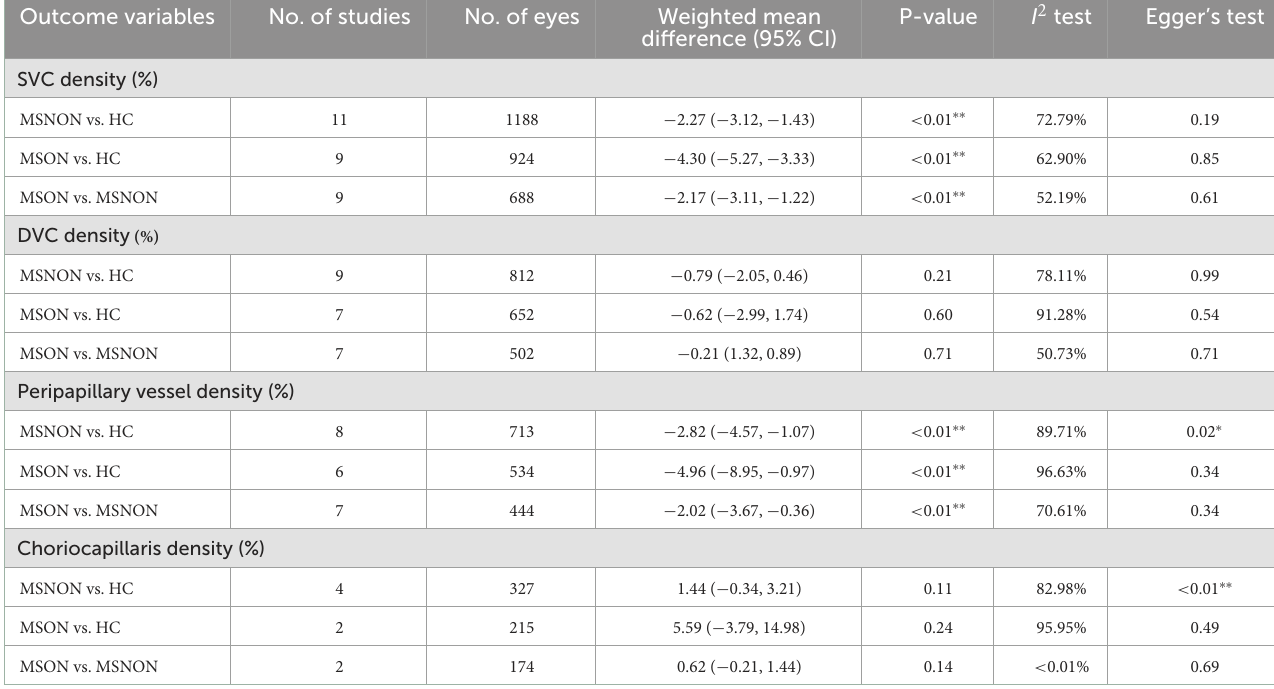
TABLE 2 Alterations of retinal and choroidal microvascular density detected by OCTA in multiple sclerosis patients with or without optic neuritis. Outcome variables